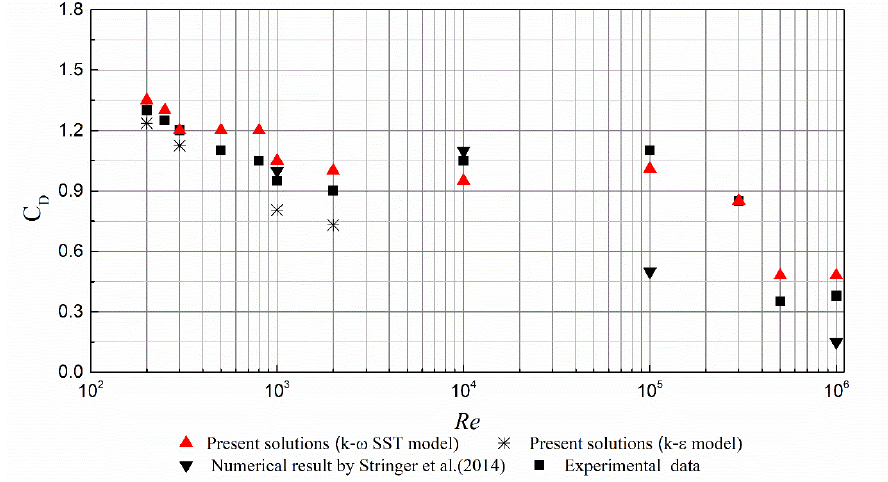
Figure 3. Validation of the mean drag coefficient which is the function of Re